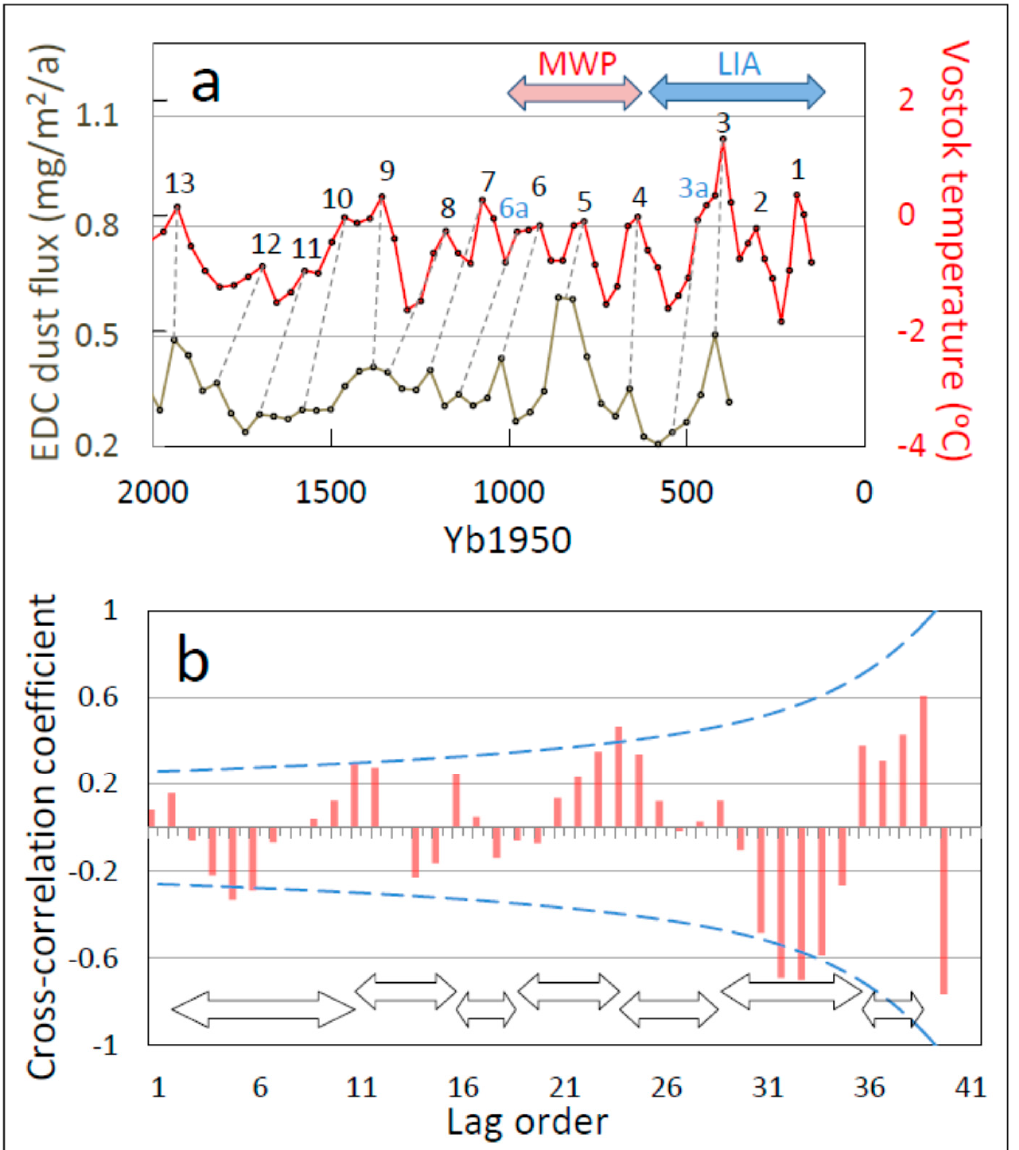
Figure 4. One-to-one coupling between temperature proxy oscillations at Vostok and dust flux (a wind proxy) at nearby EPICA Dome C (EDC) for the last two millennia. ( a ) 1:1 correspondence between wind-proxy cycles and identified temperature-proxy cycles. Wind and temperature peaks are connected by dashed lines to illustrate 100% cross-record coherence. ( b ) Cross-correlation between temperature proxies and dust flux over the period ~2000–397 years before 1950 (Yb1050). The dashed blue lines in part b represent 95% confidence limits (positive and negative) for the value of the correlation coefficient associated with different lag orders (sample sizes). Additional abbreviations: MWP, Medieval Warm Period; LIA, Little Ice Age.